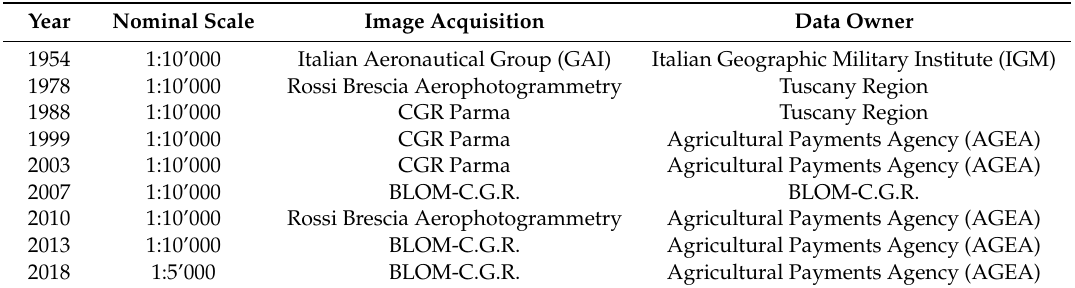
Table 1. Digital orthophotos used to create the multi-temporal sinkhole